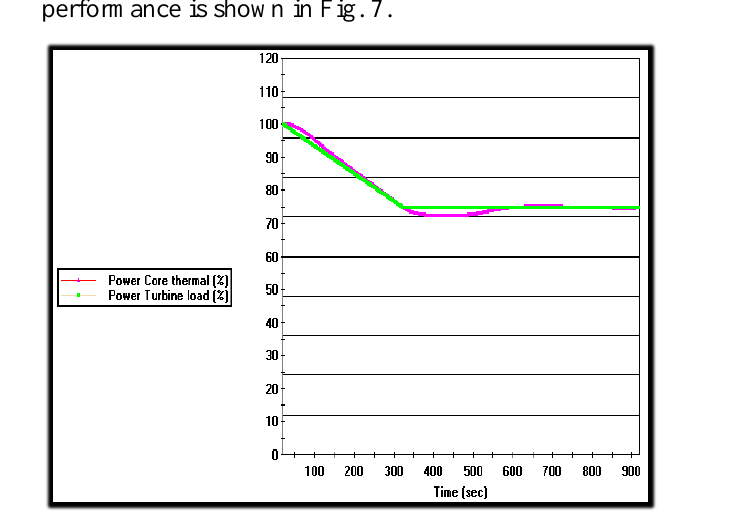
Fig. 7 . Optimization of closed loop performance for power reduction from 100% to 75% at a rate of 5%/min